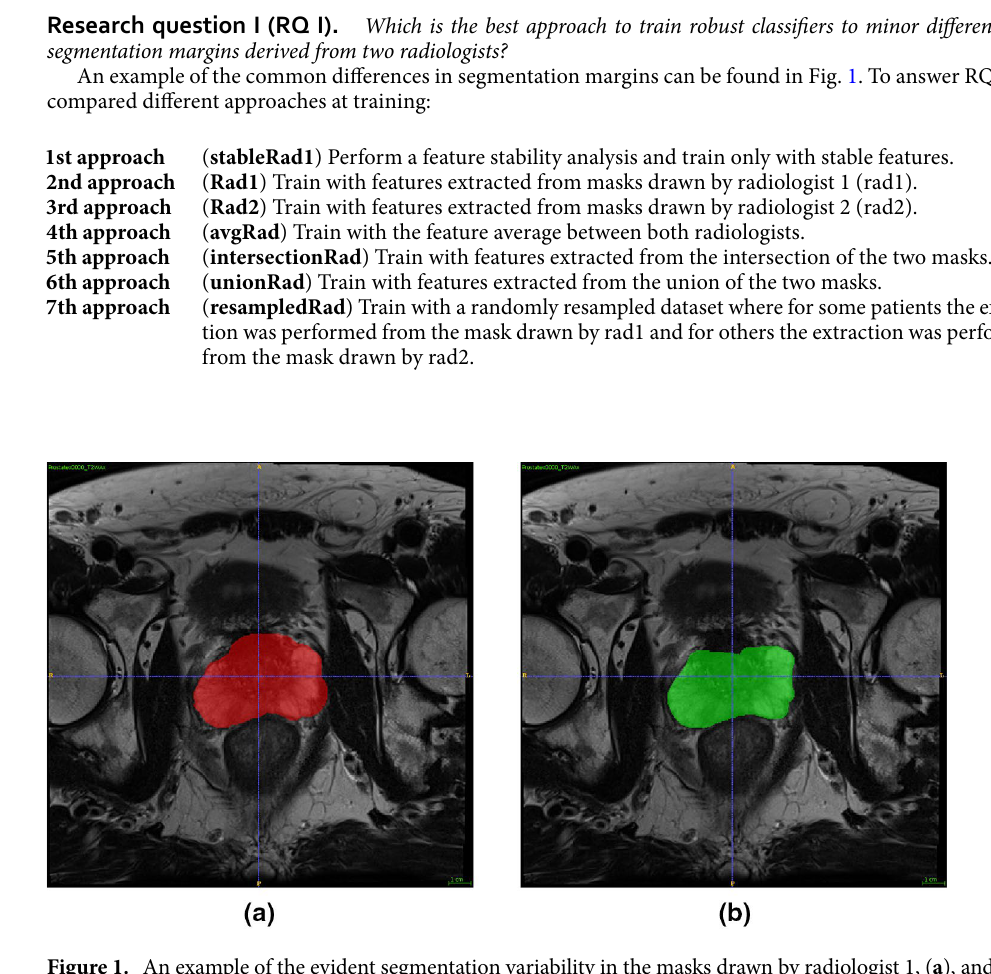
Figure 1. An example of the evident segmentation variability in the masks drawn by radiologist 1, ( a ), and radiologist 2, ( b ), on patient